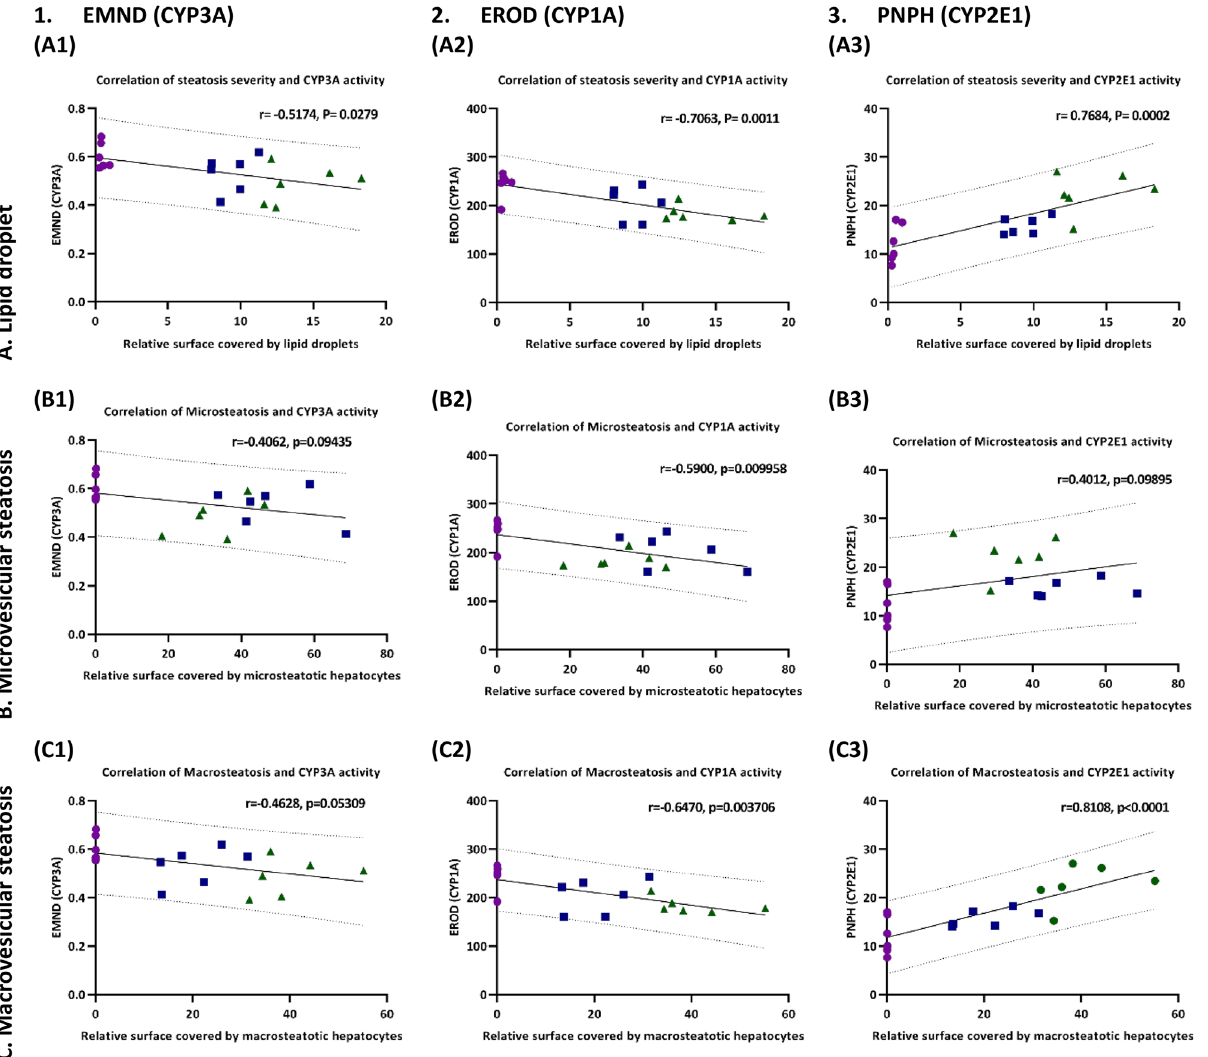
Figure 5. Correlation between steatosis severity and CYP activity. (Row A) Severity of steatosis as determined by lipid droplet analysis in percent of surface; (Row B) Extent of microvesicular steatosis, in percent of surface; (Row C) Extent of macrovesicular steatosis, expressed in percent. (Column 1) Correlation of steatosis type and severity with activity of CYP3A; (Column 2) Correlation of steatosis type and severity with activity of CYP1A; (Column 3) Correlation of steatosis type and severity with activity of CYP2E1. Control as magenta circles, two weeks HF-diet as blue squares, 4 weeks HF-diet as green